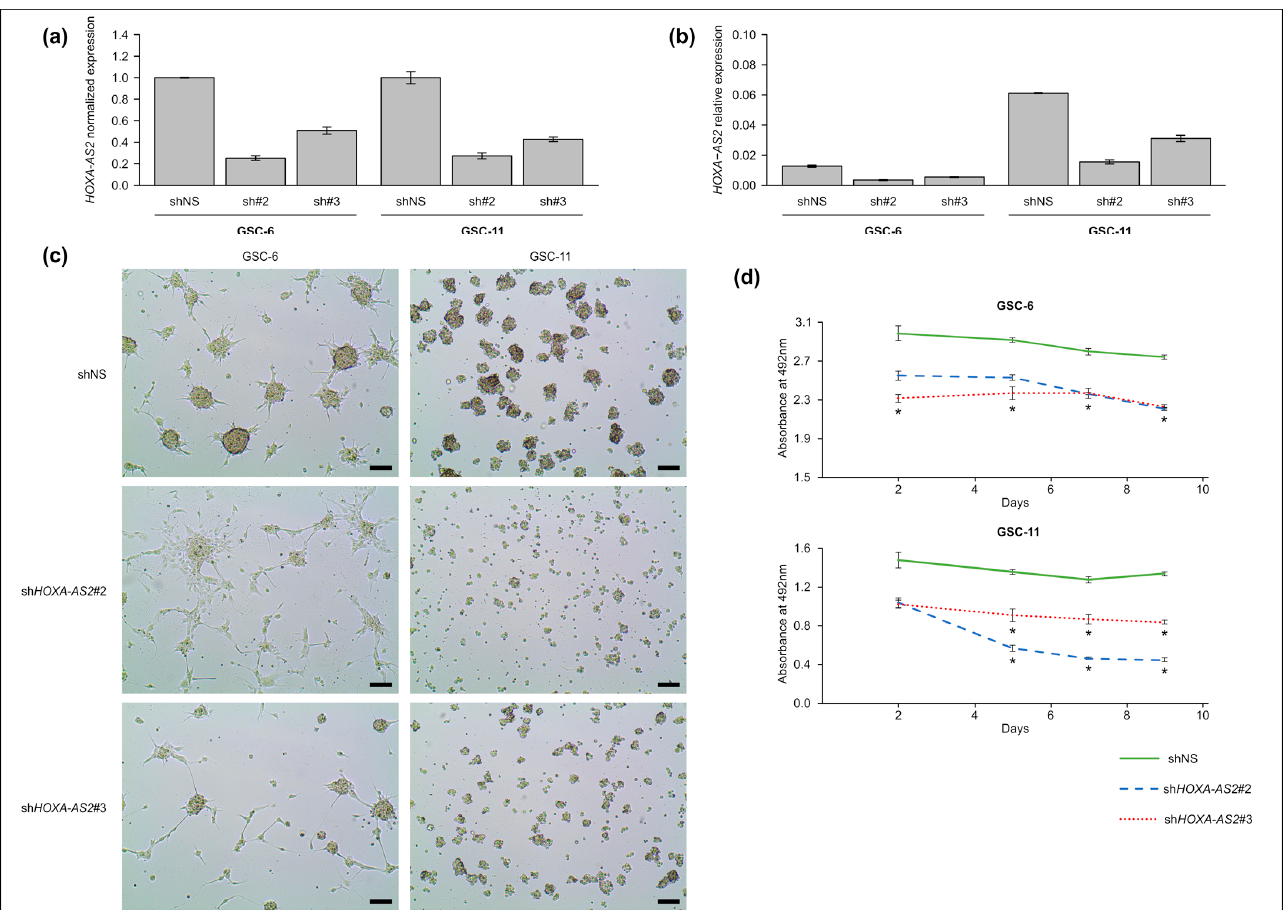
Figure 4. HOXA-AS2 knockdown in GSC lines. ( a , b ) Relative expression level of HOXA-AS2 in GSC-6 and GSC-11 cells five days after transduction with lentiviruses expressing two different HOXA-AS2 shRNAs (sh#2 and sh#3) or with a nonsilencing shRNA used as control (shNS). Values are the fold change relative to the geometrical mean of expression of the housekeeping genes PPIA , TBP , and HPRT1. Data are presented as relative expression normalized ( a ) and not normalized ( b ) to the expression level in shNS cells. ( c ) Representative images of neurosphere formation in GSC-11 and GSC-6 cells five days after transduction with lentiviruses expressing two different shRNAs (shHOXA-AS2#2, #3) or with a nonsilencing shRNA used as control (shNS). Scale bar = 100 μ m. ( d ) Growth curves of GSC-6 and GSC-11 cells after HOXA-AS2 silencing or not at days 2, 4, 7, and 9 after transduction; * p < 0.05 (Mann–Whitney test).